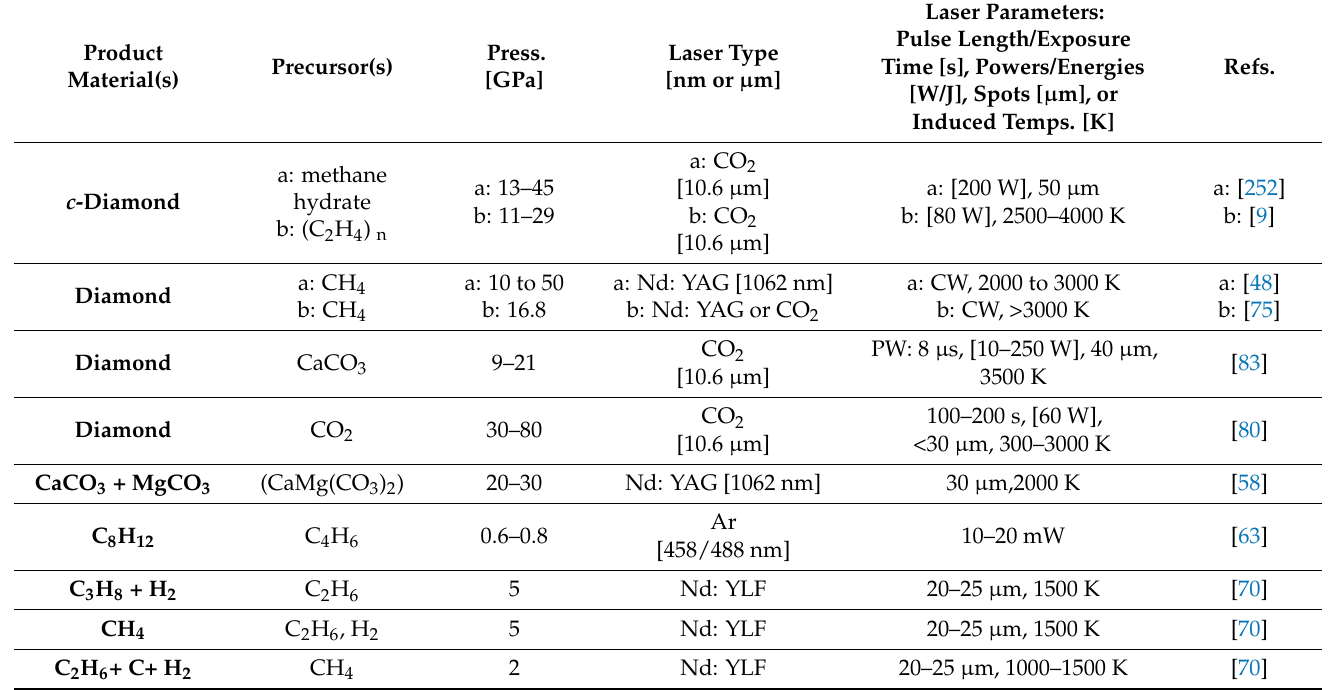
Table 1. Low-Z, Carbon-Containing Compounds: Low-Z Carbon-Containing Materials Synthesised During Selected LRS-DAC